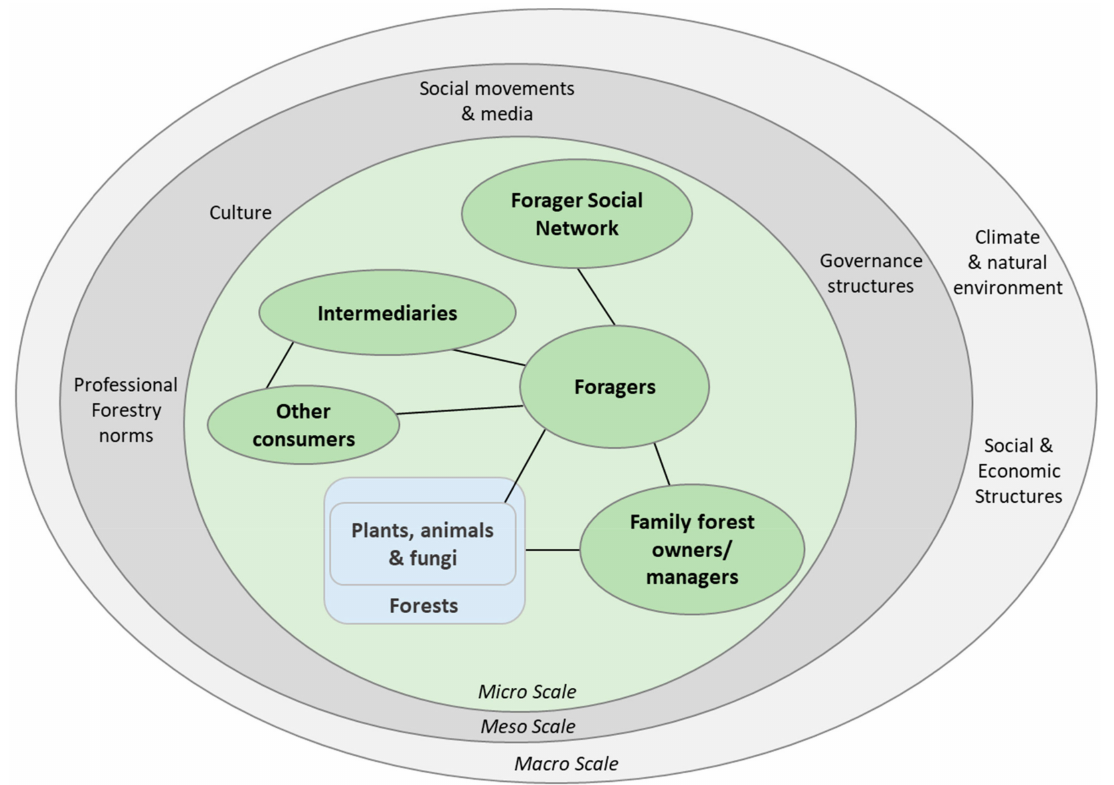
Figure 1. Non-wood forest product collection through a service-dominant logic